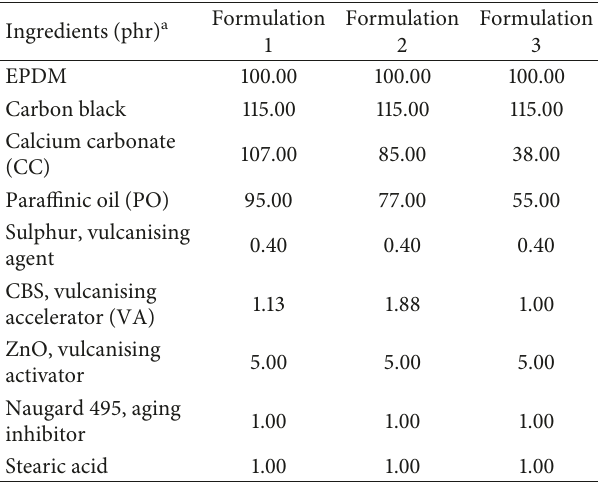
Table 9: Examples of optimised EPDM rubber composites with costs between 1.92 and